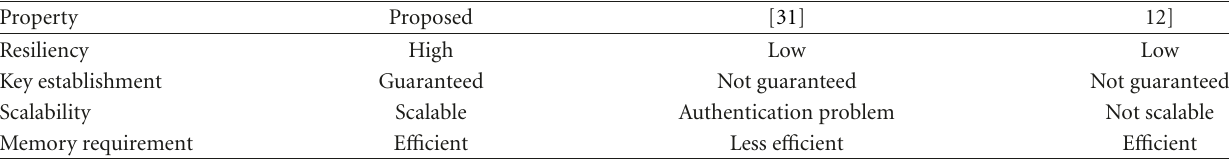
Table 4: Comparison of the proposed scheme with recent existing